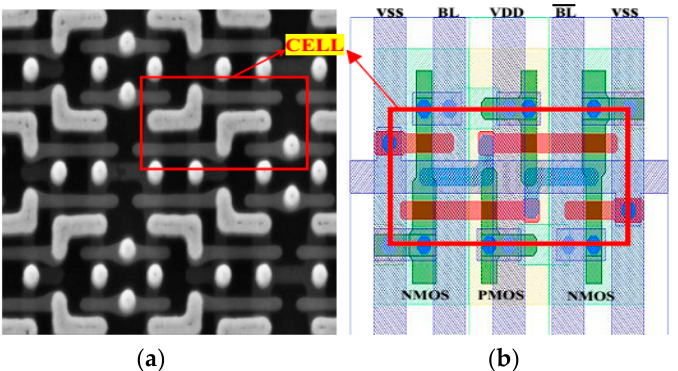
Figure 1. A photomicrograph ( a ) and cell layout of HM62V8100i static random-access memory (SRAM) ( b ).